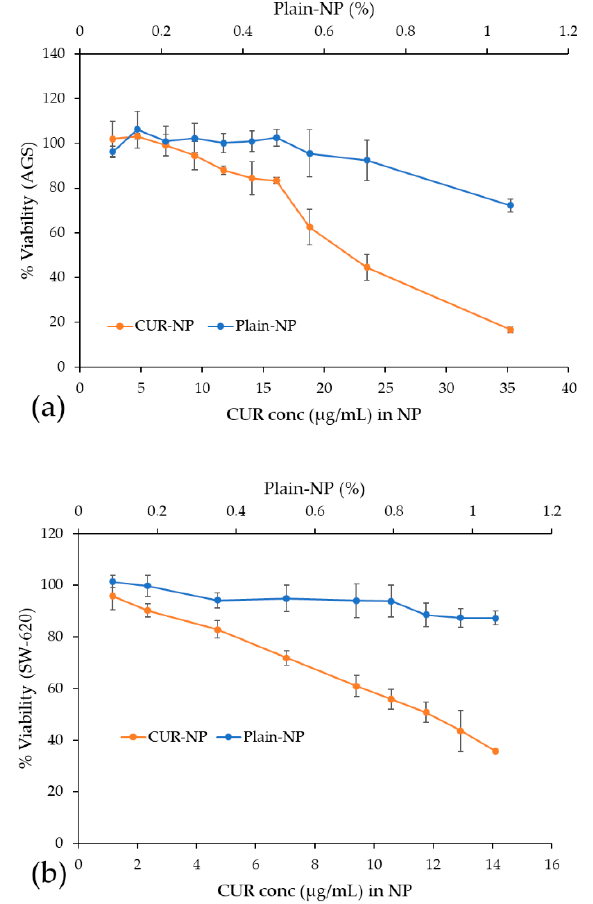
Figure 6. Cytotoxicity dose–response curves of CUR-NP and Plain-NP in AGS and SW620 tumor cell lines. Results are presented as mean ± SD of three independent experiments. ( a ) Samples in AGS cells ( b ) Samples in SW620 cells.